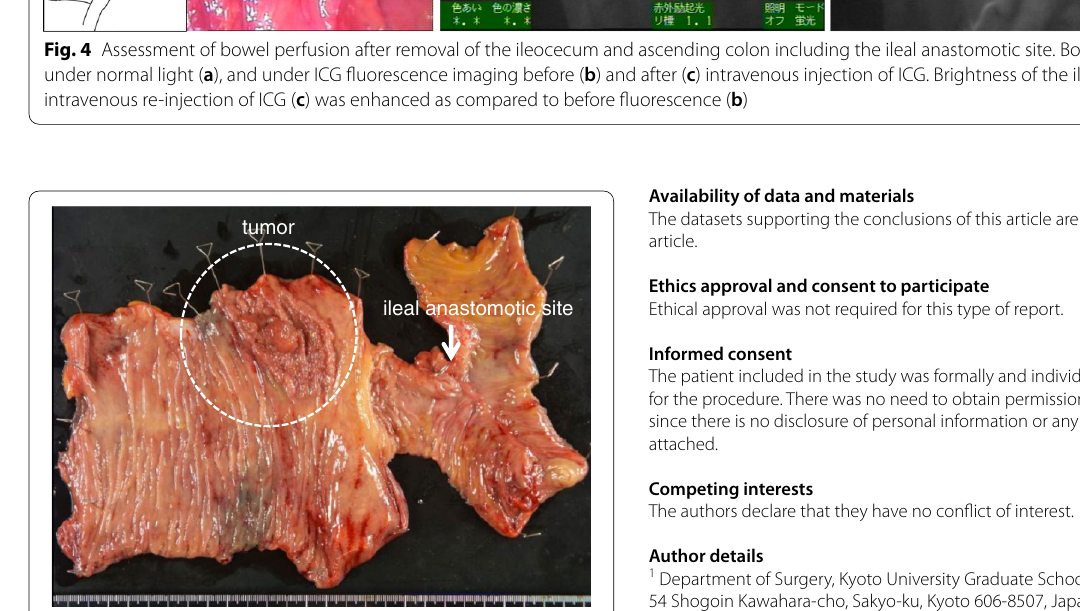
Fig. 5 A specimen from the ileal anastomotic site to the ascending colon, including the tumor. Histological examination confirmed adenocarcinoma limited to the mucosal layer and without lymph node